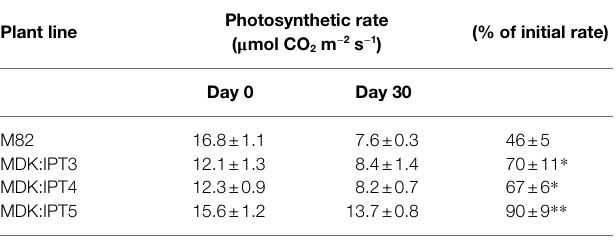
Values represent the mean measured values of six replicates at day 0 (fully expanded leaf), 30-day-old leaves and the percentage of the values measured in old leaves from those measured in young fully expanded leaves. Plants were grown in a temperature- controlled greenhouse (25/18 ° C day/night). Data represent means (±SE). Student’s t-test was used to compare mean values of four plants. Asterisks indicate significant differences between each transgenic line and the control variety M82 by Student’s t-test at p < 0.05 ( * ) and p < 0.01 ( **